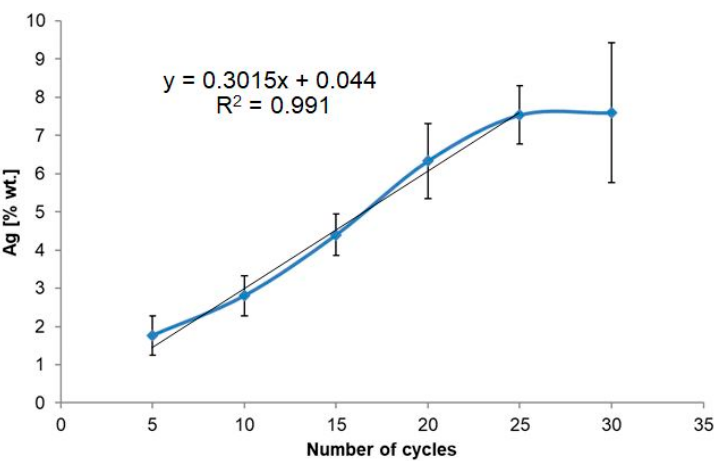
Figure 3. Chart presenting a number of deposition cycles dependence on silver weight content in produced AgNPs/TNT platforms.